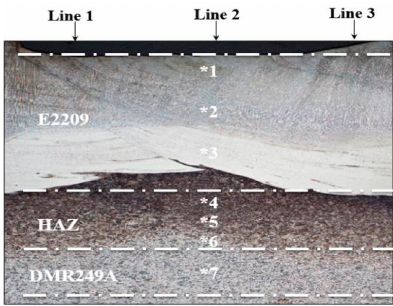
Figure 6. Micro-hardness test location at the cross-section.